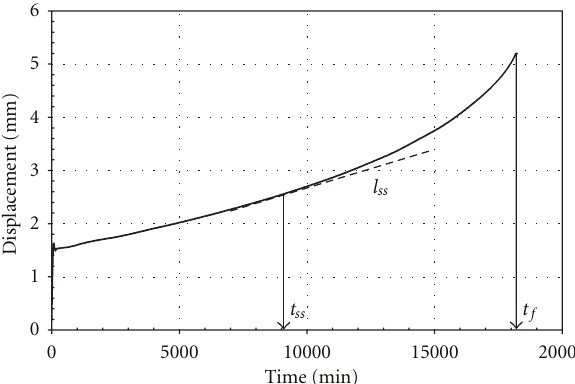
Figure 2: The corrosion elongation curves for A5052-H3-LT at T = 353K and σ = 240MPa in 0.5M sodium chloride solution.